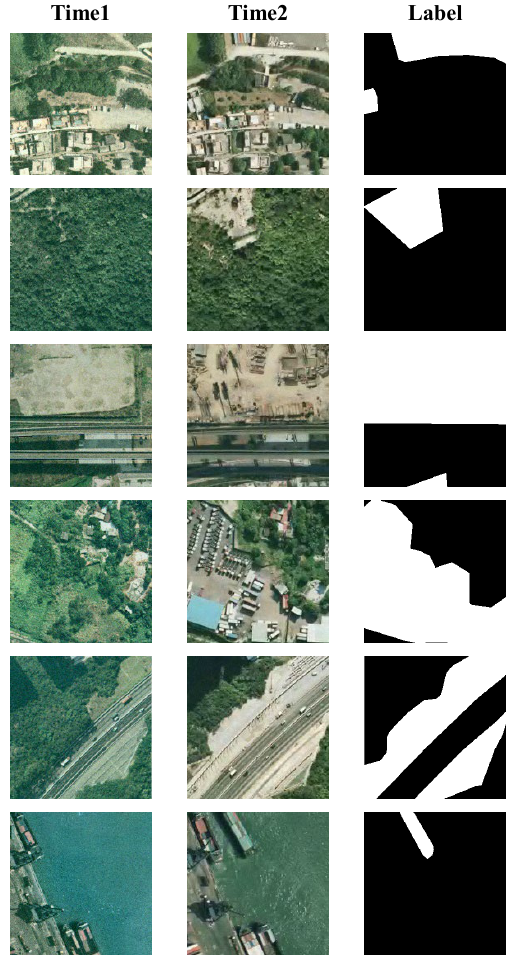
Figure 1 Example of the SYSU-CD dataset